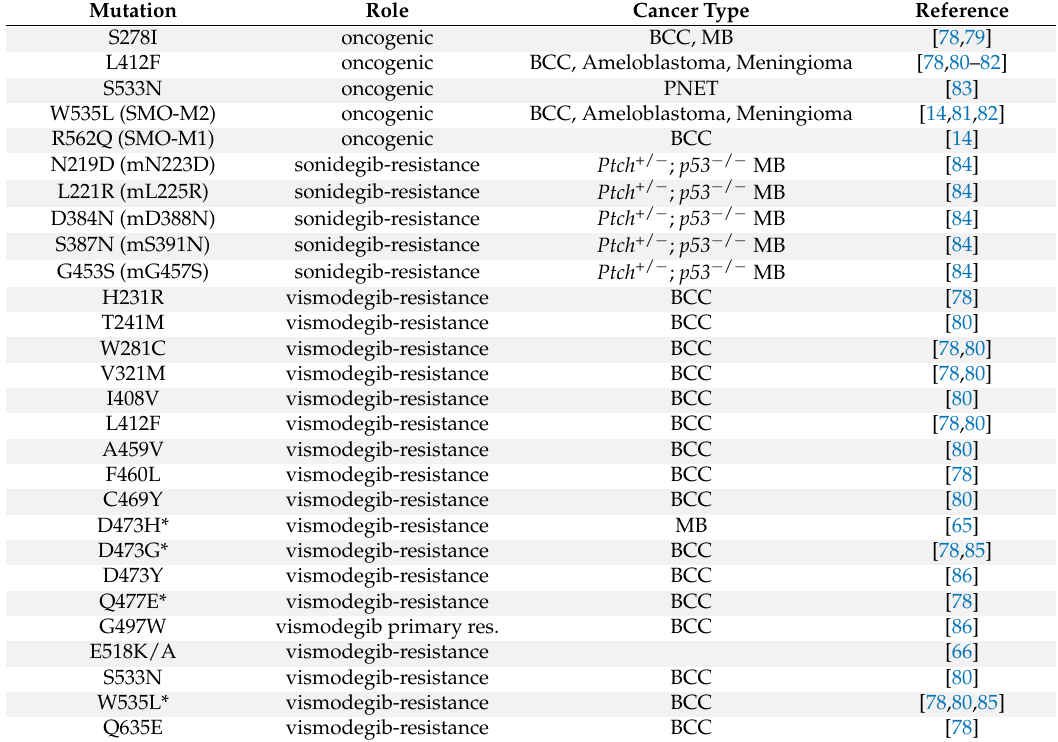
Table 1. Oncogenic and resistance-associated SMO